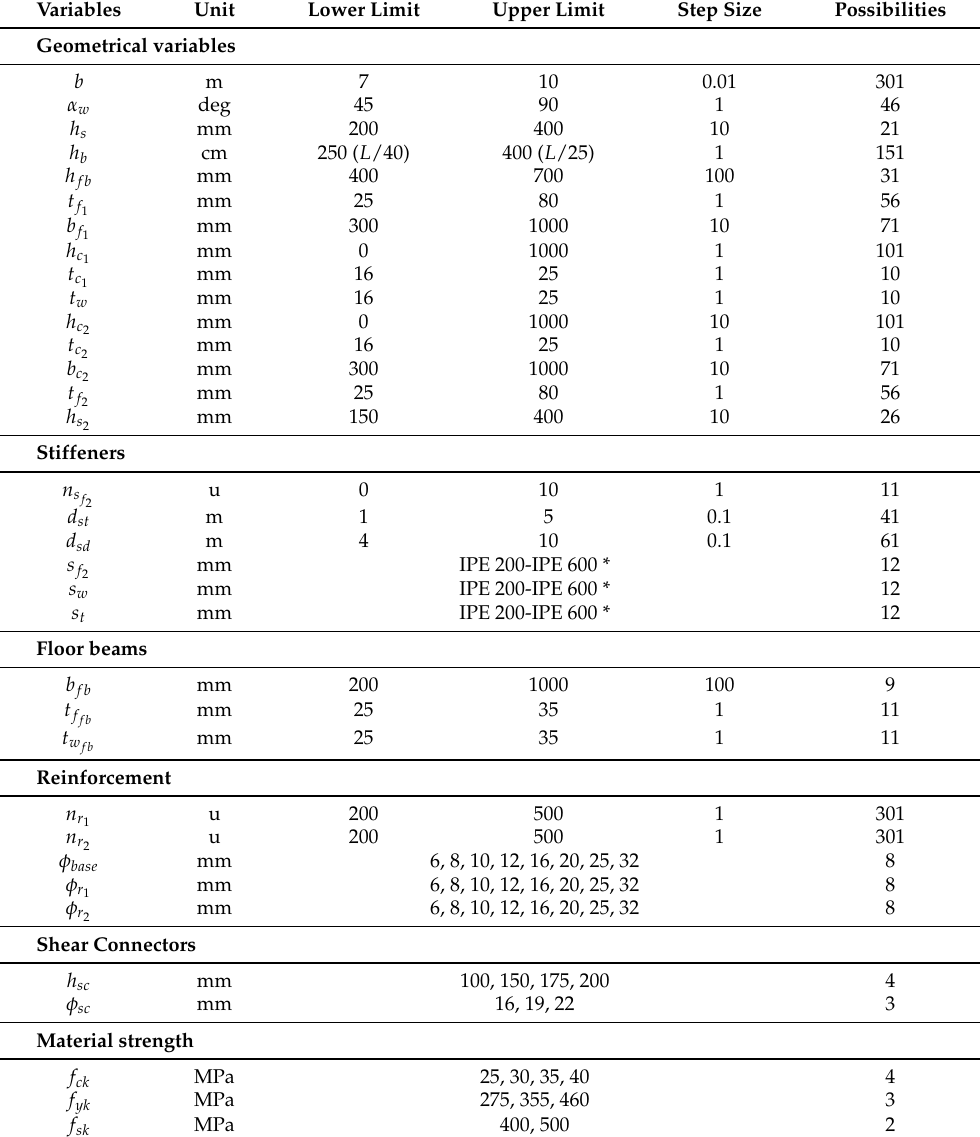
Table 2. Optimization problem variables and